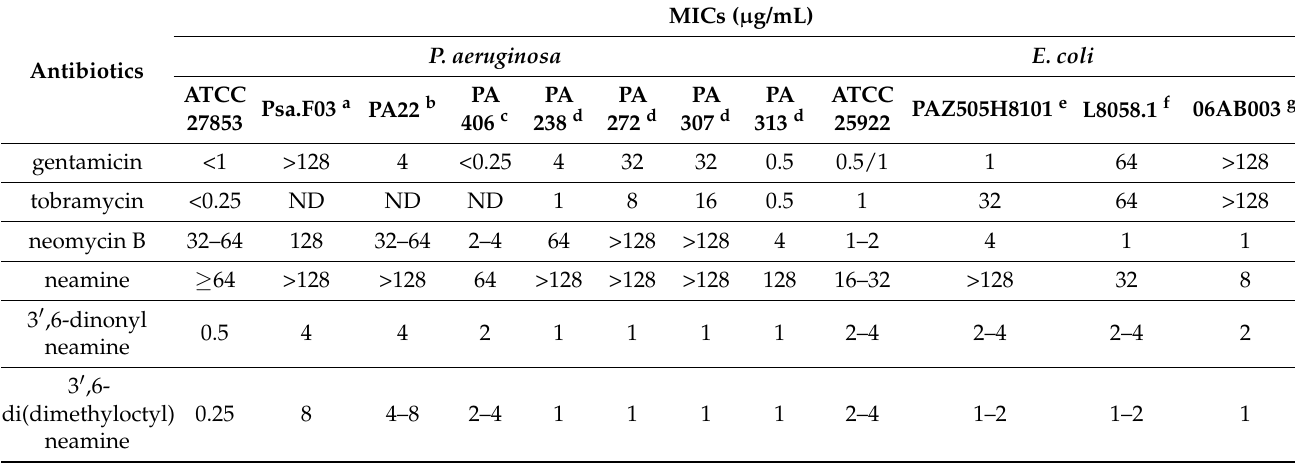
Table 1. MICs of 3 (cid:48) ,6-dinonyl neamine and 3 (cid:48) ,6-di (dimethyloctyl) neamine against wild-type and resistant P. aeruginosa and E. coli clinical strains in comparison with those of gentamicin, tobramycin, neomycin B, and neamine.